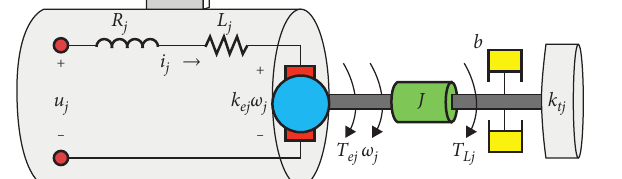
Figure 1: The system framework.